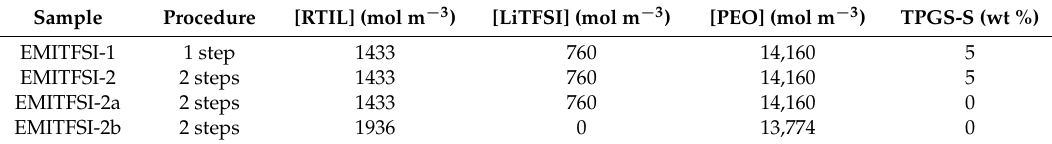
Table 1. Formulation and nomenclature of the polymer